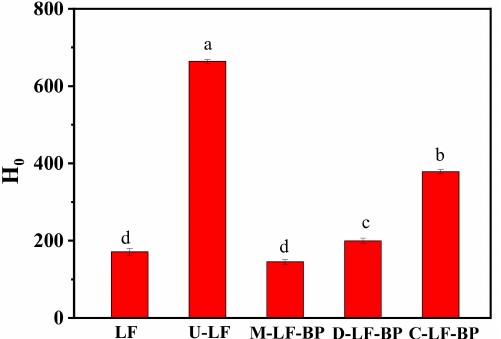
Figure 5. Surface hydrophobicity of LF, U-LF, M-LF-BP, D-LF-BP and C-LF-BP. Bars with di ff erent letters are significantly di ff erent from each other ( p < 0.05